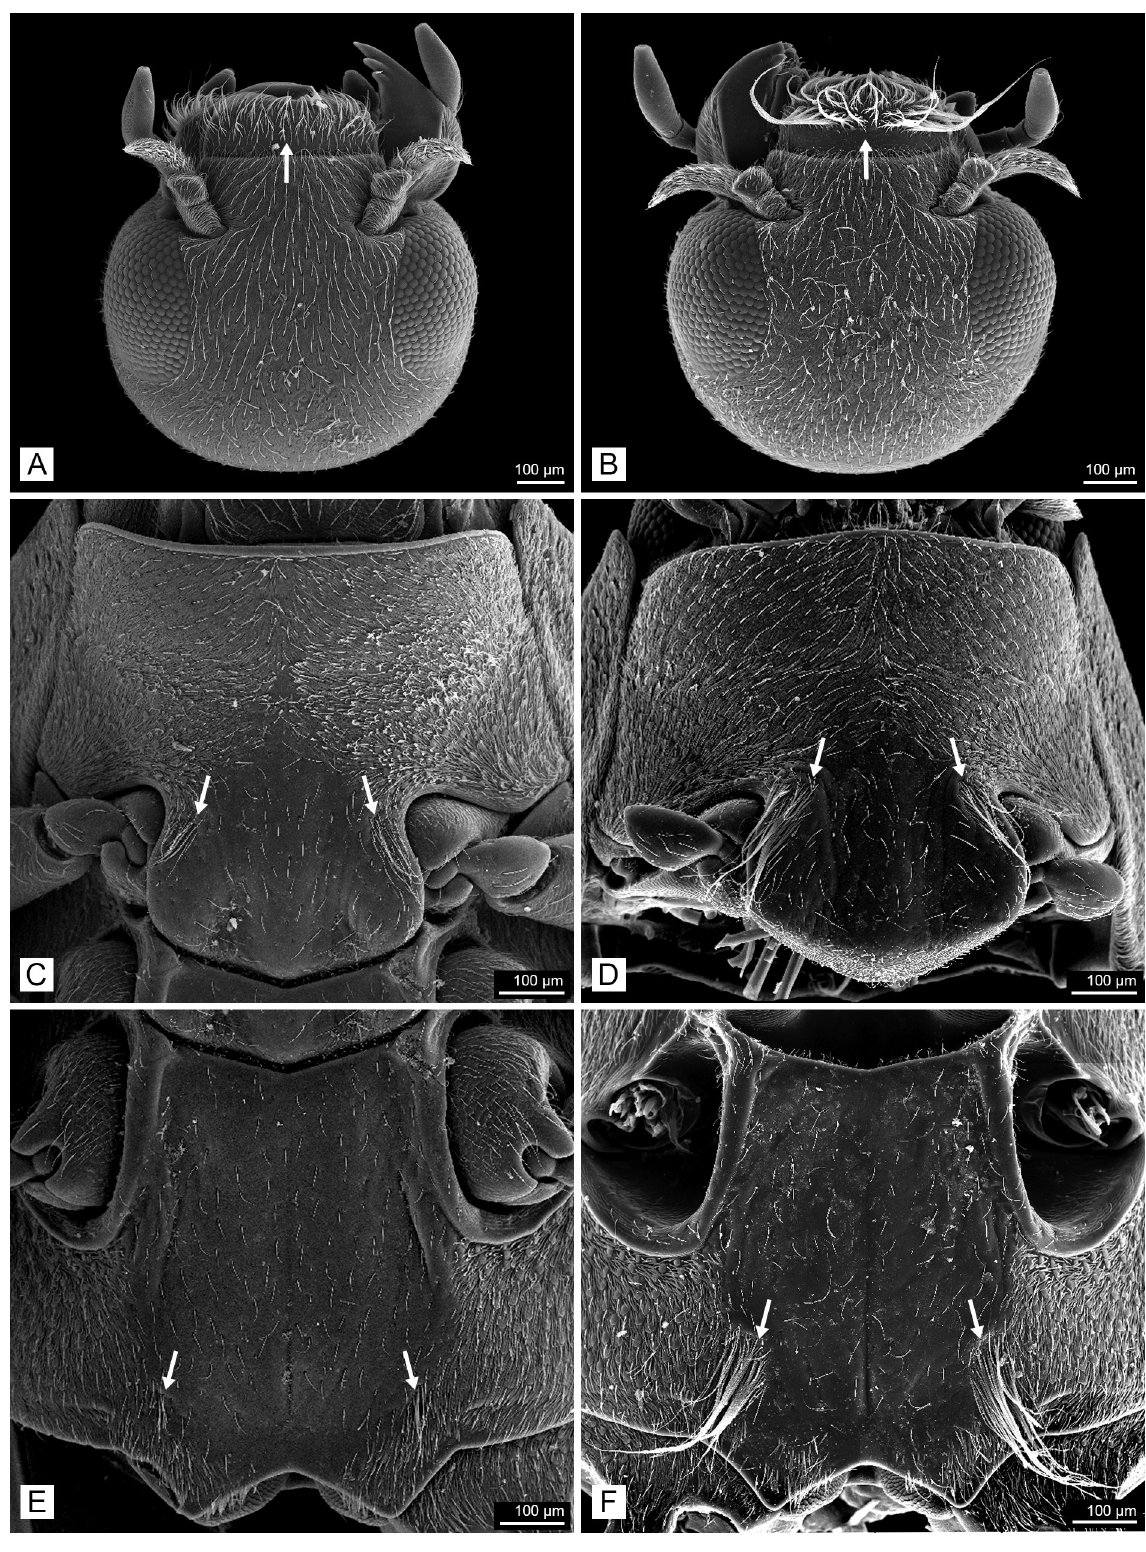
Fig. 6. Details of the male head and ventral portions. A, C, E . Elmomorphus brevicornis Sharp, 1888 (JKCB). B, D, F. Elmomorphus amamiensis Nomura, 1959 (JKCB). A–B . Head. C–D . Ventral view of the prothorax. E–F . Ventral view of the metathorax. Arrows show the position of setal